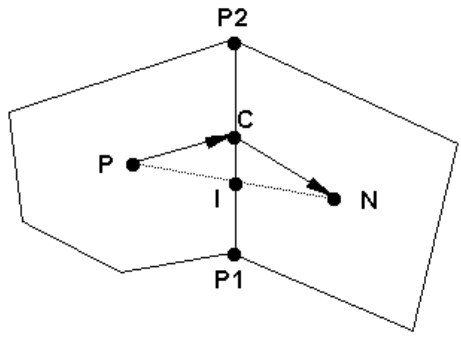
Figure 1. Schematic illustrating a polygon mesh cell (P) and its neighbor cell (N).